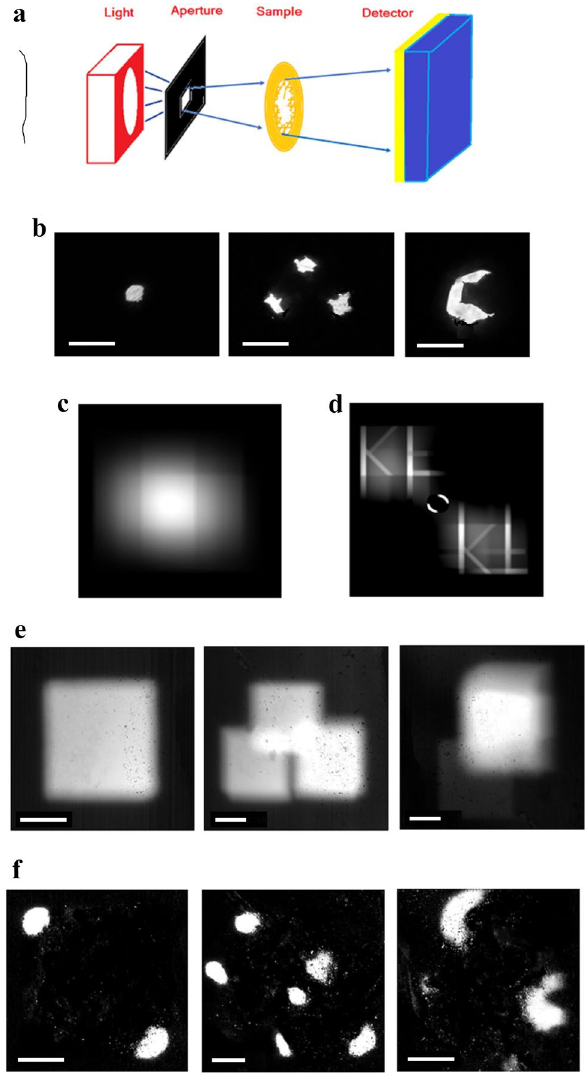
Figure 3. ( a ) The experimental setup of a non-point light source of wavelengths centered around 550 nm, square aperture by 2 perpendicular slits of 1 mm separation via thin metal strips, sample by a pinhole punched metal foil, and 3 × 5mm 2 image sensor from a digital camera, with the lens assembly removed. The aperture- detector distance is about 50 mm, with the sample placed in between. ( b ) microscope photos of the samples made of metal foil; one pinhole on the left; triple pinholes in the middle, and the letter “C” to the right. Scale bar length: 300 µm. ( c ) For a common non-point light source, the intensity may not be uniformly distributed across the square aperture. Thus Fig. 2b was recalculated by incorporating a Gaussian decaying factor of exp(− R 2 /R o2 ) on top of a square g(x’,y’), where R is the radius from the center, and R o is about 70% of the half width of g. ( d ) Despite the resulting p(x,y) starts to show some artifacts, the de-convolution of 3c is similar to Fig. 2c, due to the fact that it is slowly-varying, when compared with the letters. ( e ) The resulting photos from the metal foils in 3b, taken by a CMOS sensor of digital camera: on the left, almost a perfect square like spot is produced by the light source through a single pinhole in 3b; in the middle, three overlapping squares are formed by the triple pinholes in 3b; to the right, the “C” in 3b leads to a square-like bright spot. Scale bar length: 400 µm. Note that these squares are the smallest spots attainable due to the finite sized light source, where the original pinholes and letter “C” are blurred. ( f ) The de-convolution results of 3e by Matlab™ command in 2d: on the left, the “square” produces after the “square aperture difference” a pair of bright dots, corresponding to the two red dots in 1c; in the middle, the triple pinhole forms two sets of triplets, with one on the upper left and the other on the lower right; to the right, the doubled “C”s are evident, despite the noise. Scale bar length: 400 µm. Compare with 3e, the resolution is much improved and the blurred images are now